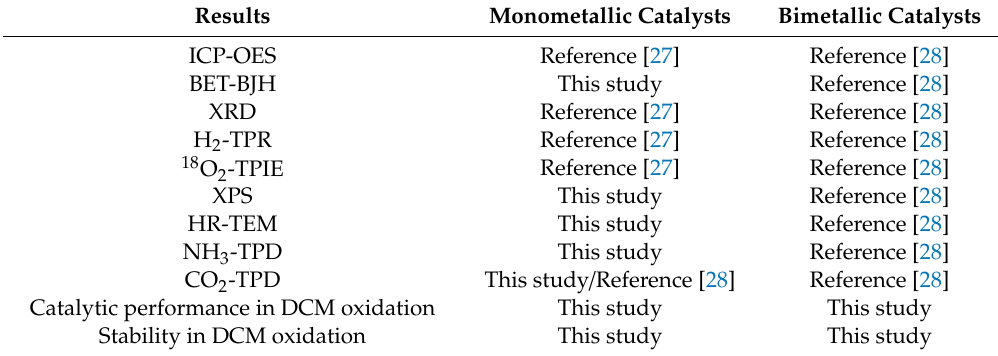
Table 1. Summary of the previously published results in References [27,28] and the new results presented in this study. DCM: dichloromethane, ICP-OES: inductively coupled plasma optical emission spectroscopy, BET-BJH: Brunauer-Emmett-Teller / Barrett-Joyner-Halenda method, XRD: X-ray di ff raction, XPS: X-ray photoelectron spectroscopy, HR-TEM: high-resolution transmission electron microscope, H 2 -TPR: temperature-programmed reduction with hydrogen, 18 O 2 -TPIE: temperature-programmed isotopic exchange (TPIE) of labeled oxygen, NH 3 -TPD: temperature-programmeddesorptionofammonia, andCO 2 -TPD:temperature-programmeddesorption of carbon dioxide.